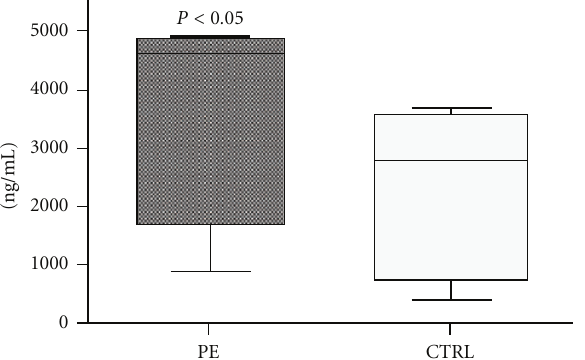
Figure 3: Analysis of serum levels of MBL in pre-eclamptic and control women. The level of oligomerized MBL in sera was measured using an MBL oligomer ELISA kit. The results are expressed as box plot graphs, in which the line in the middle of the box represents the median; the lower and the upper edges of the box are the 1st and 3rd quartile,